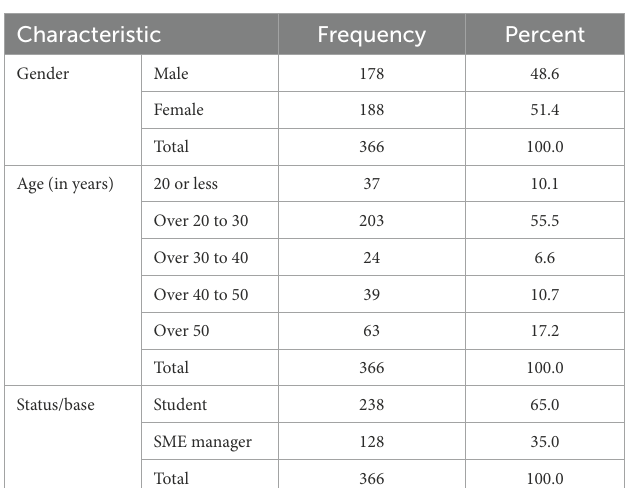
TABLE 1 Characteristics of